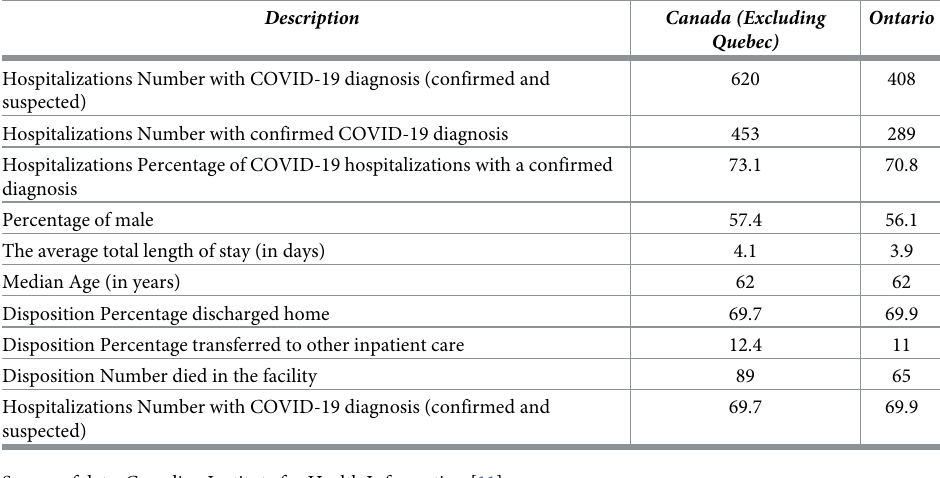
Table 1. COVID-19 hospitalizations of dialysis patients (including intensive care unit admissions) and associated characteristics in Ontario and Canada (January to March 2020). Description